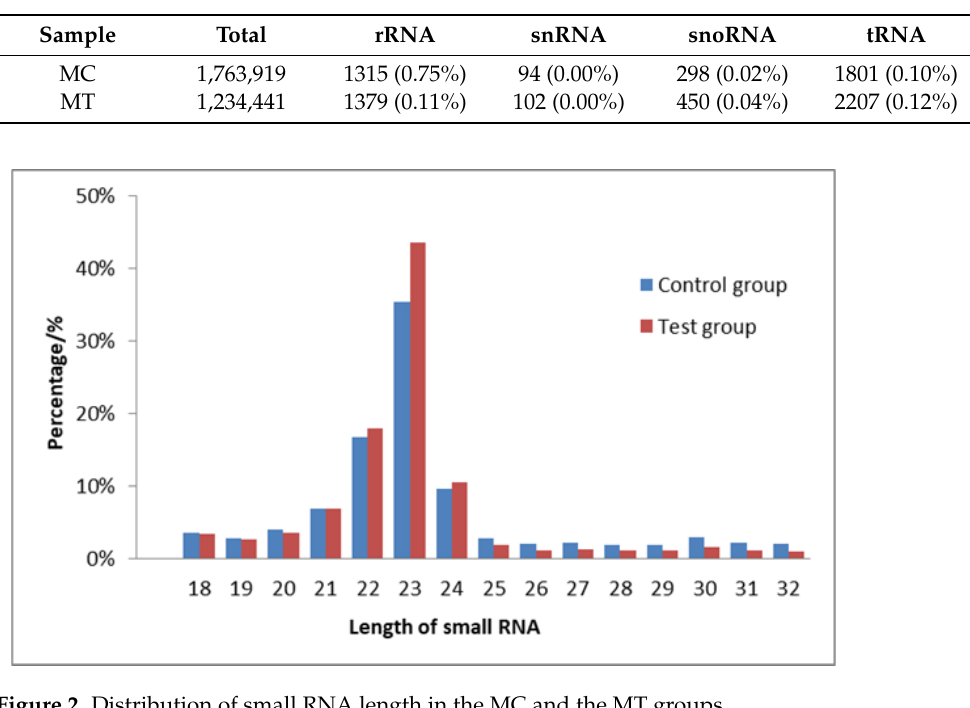
Table 3. The tag abundance statistics of non-coding RNA in Rfam were compared between MC and MT groups.